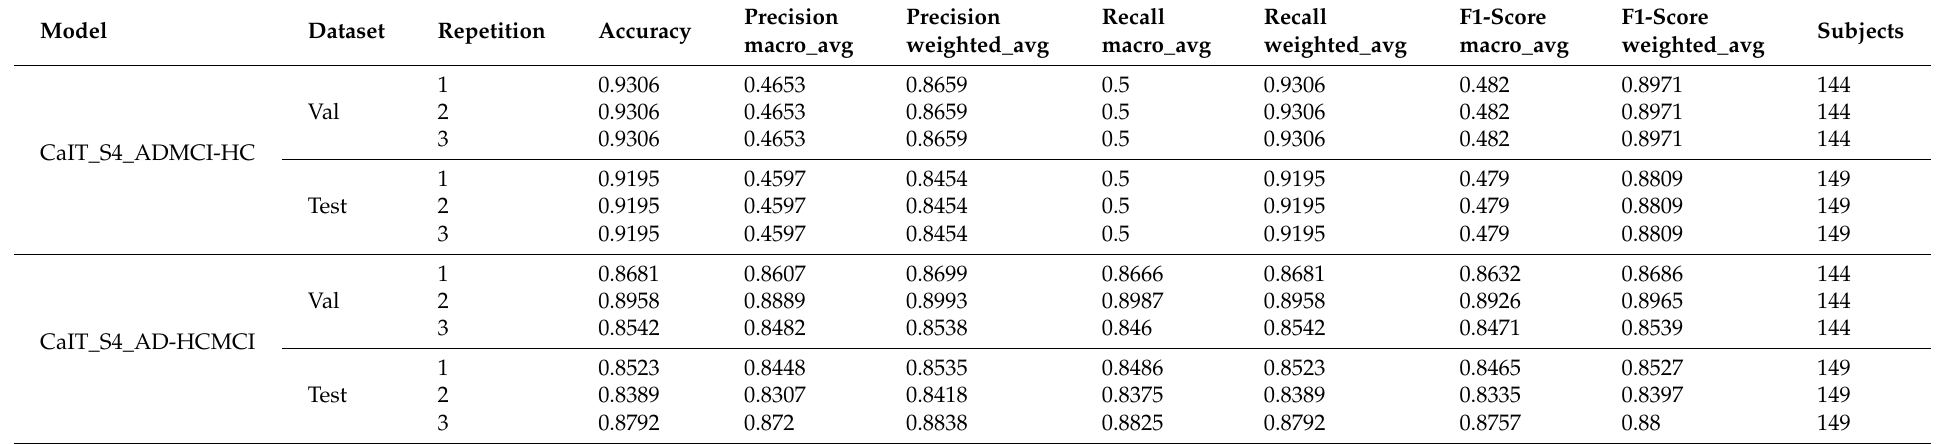
Table A6. The performance of structural MRI models at subject-level for preprocessed data using spatial smoothing with sigma = 4 mm (S4). The naming convention for models and classes is as in the previous